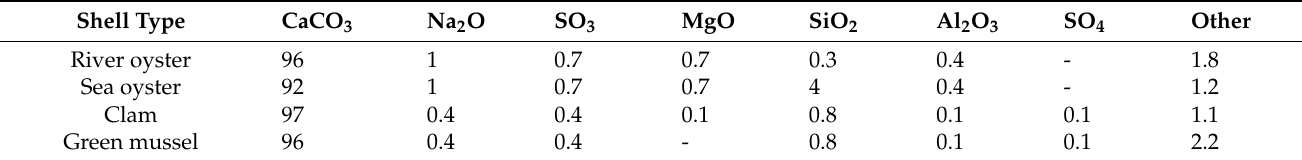
Table 1. Chemical composition (%) of various raw bivalve shells. Adapted from Zhan et al. [7]. Their habitat location and shell type determine their exact chemical composition. When calcined (pyrolysed), shell chemical composition modifies, as calcium carbonate (CaCO 3 ) converses into lime (CaO).